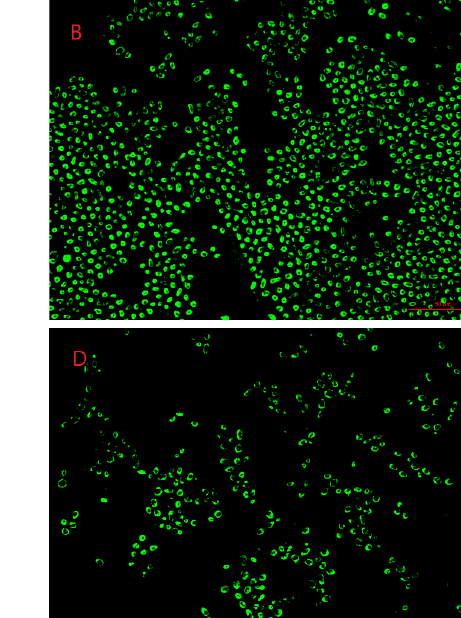
Figure 3. Effects of D. officinale on the cell viability of S. cerevisiae . T0, T3, and T10 were the samples with 0, 30, and 100 g/L of D. officinale , respectively. Different letters indicate significant differences at p < 0.05. ( A ): value of cell viability; ( B ): T0; ( C ): T3; ( D ): T10.